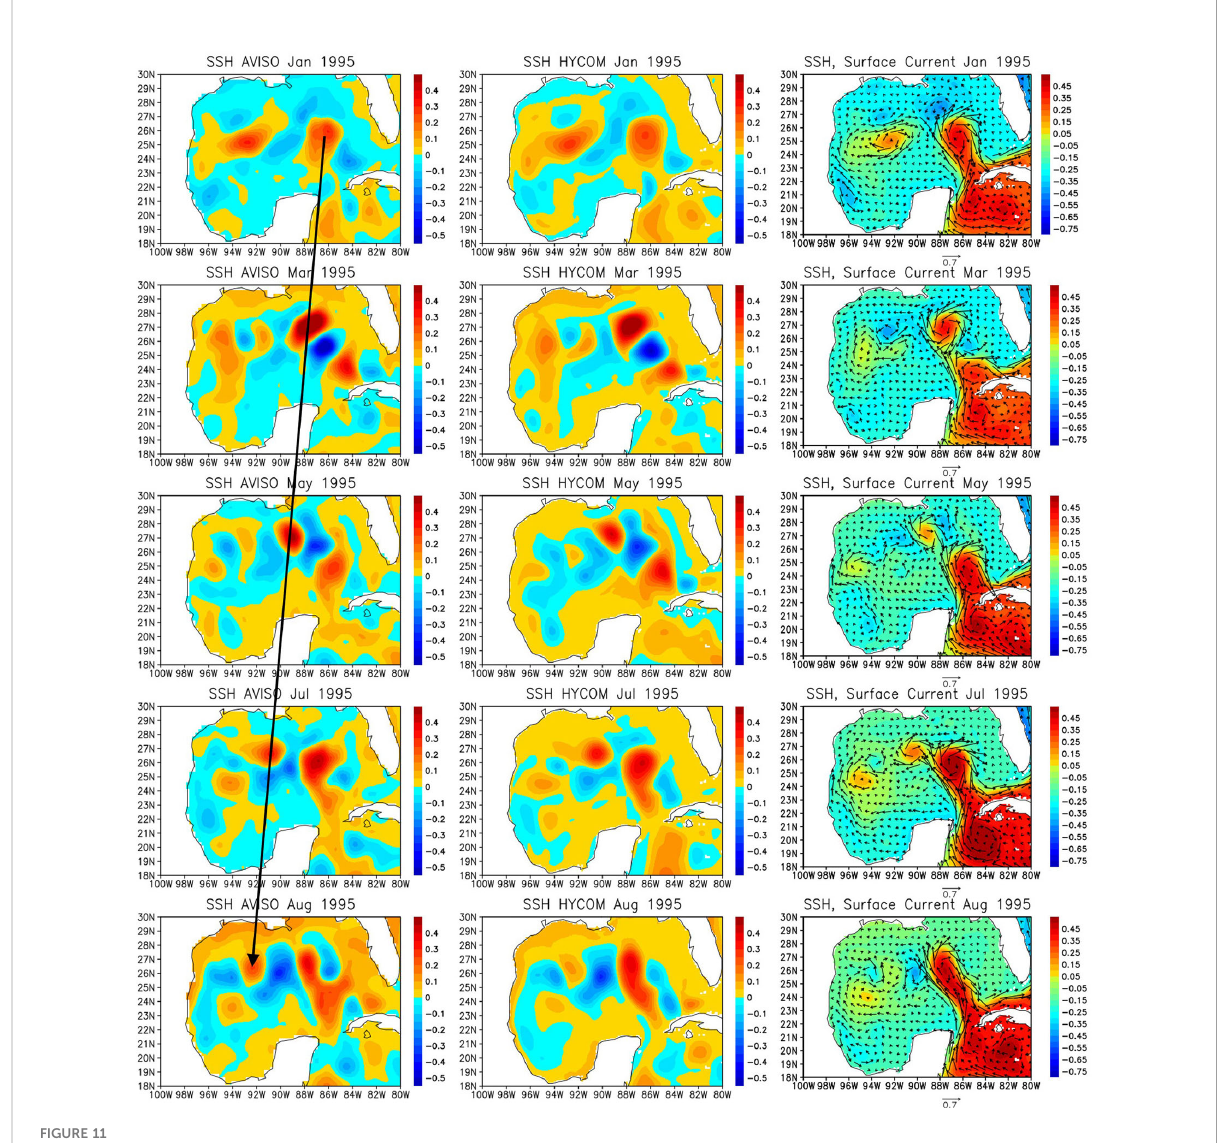
FIGURE 11 Same as Figure 6 except for January, March, May, July, and August,